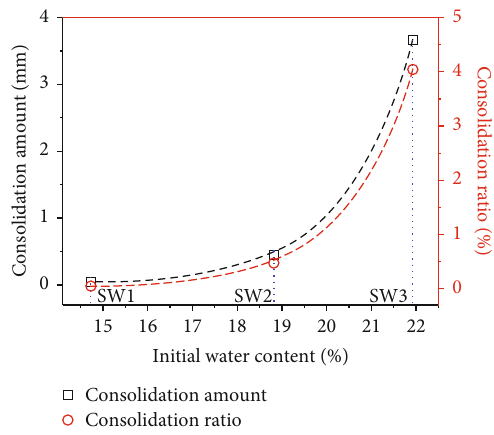
Figure 10: The relationship between consolidation and initial water content.